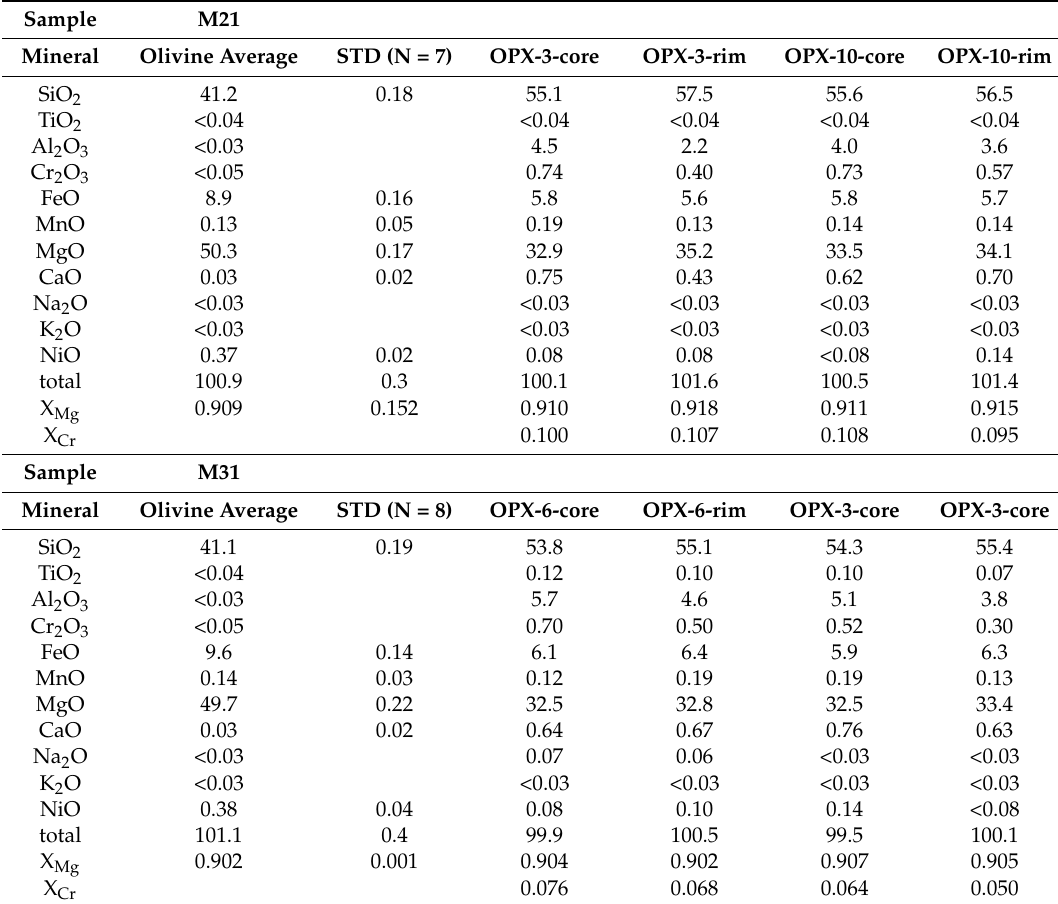
Table 1. Representative compositions of olivine and orthopyroxene.